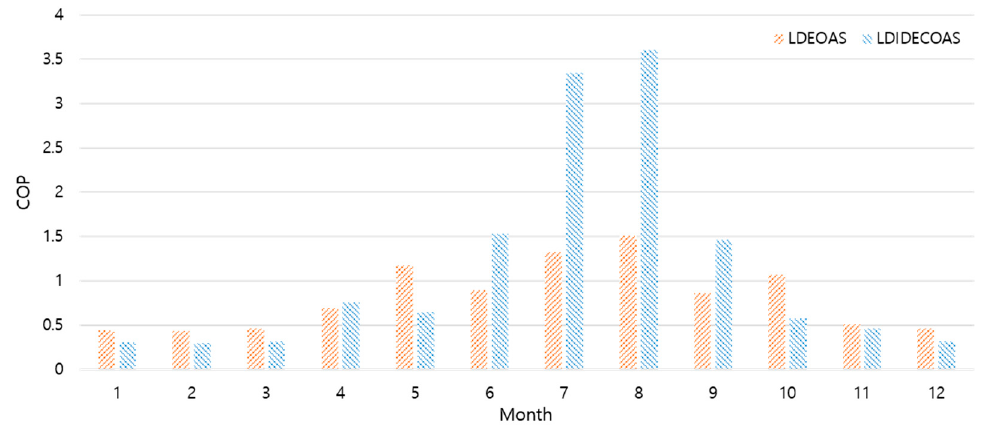
Figure 12. Comparison of monthly coefficient of performance (COP).